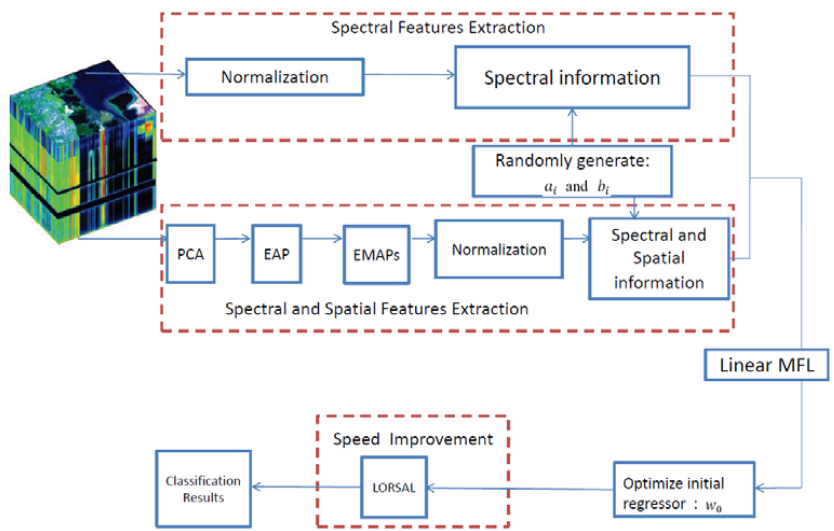
Figure 1. The flowchart of the proposed extreme sparse multinomial logistic regression (ESMLR)